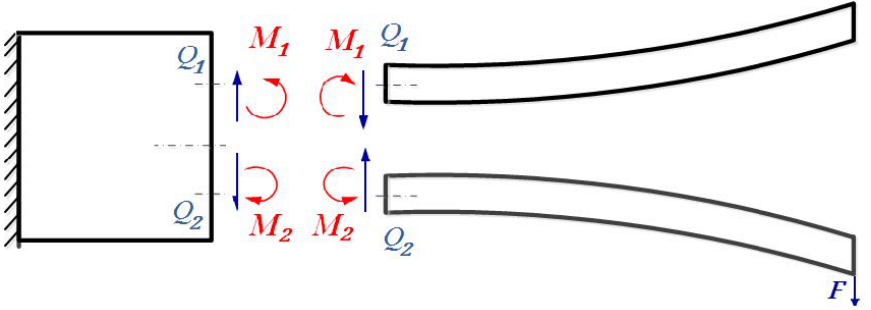
Figure 4. Shear force and bending moment acting on the proof mass and the prongs at the interfacial area in the case of free vibration.